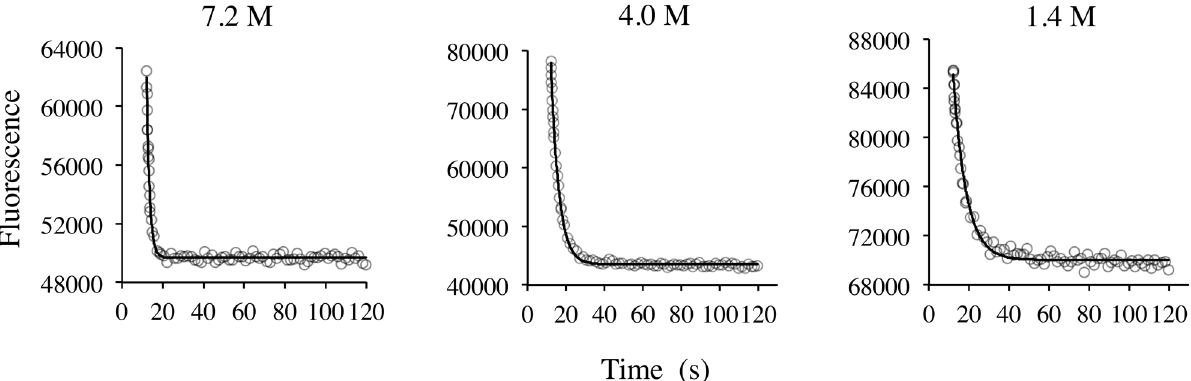
Fig 1. Representative kinetic traces generated from our plate reader method for AbpSH3 WT. The final guanidine concentration is at the top of each graph. Excitation is at 280 nm and emission is at 330 nm. The black line is fit to an exponential decay (Eq 2). Guanidine injection starts at 10 s.